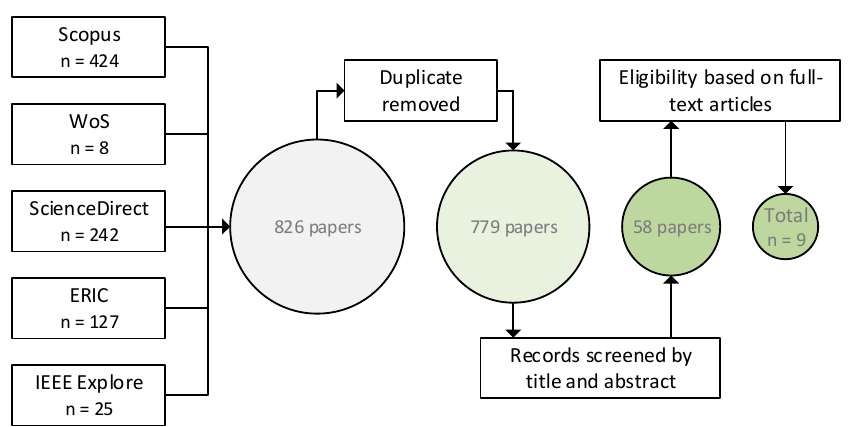
Figure 1. Flow chart for article selection.